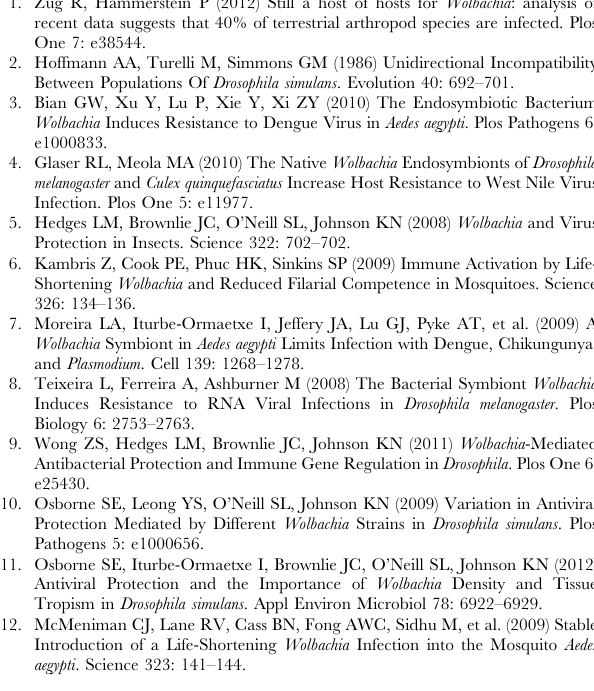
Figure key: Wolbachia -infected flies - dashed lines with rhomboid markers, uninfected flies – solid lines with square markers, PBS controls – dotted lines with circle markers, Standard diet – black line, Intermediate diet – red lines, High diet – blue lines. Mean ( 6 s.e.m.) total cholesterol and cholesteryl ester levels for flies in the six experiments above - w MelPop experiments two ( G ) and three